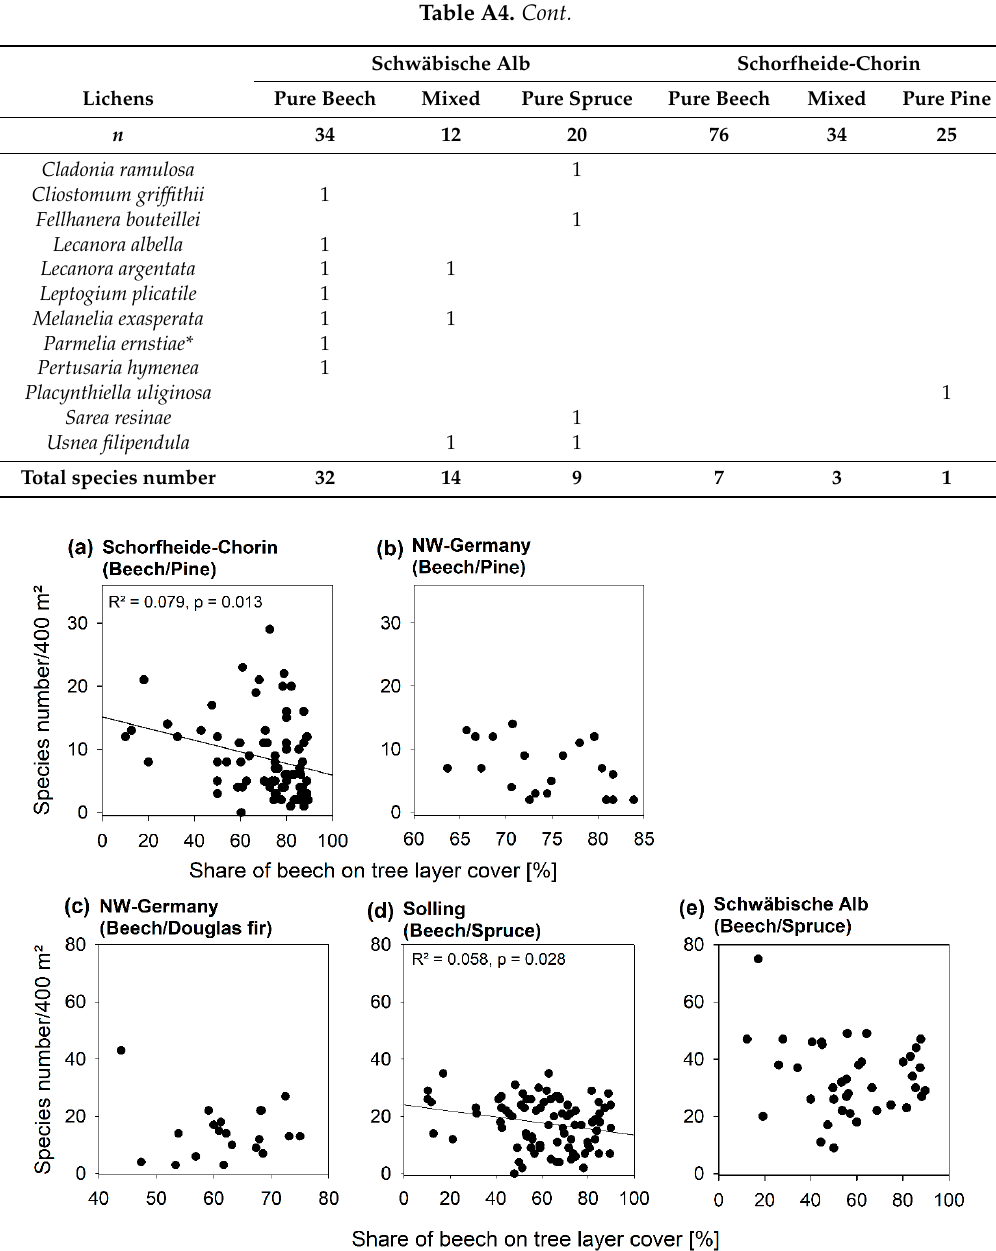
Figure A1. Vascular plant species numbers per 400 m 2 plots in relation to the percentage share of beech on tree layer cover within mixtures ( a ) of beech and pine in Schorfheide-Chorin and ( b ) NW-Germany, ( c ) of beech and Douglas fir in NW-Germany, ( d ) beech and spruce in Solling and ( e ) Schwäbische Alb. Plots were characterized as mixtures when both target species (beech and conifer) had a minimum of 10% or maximum of 90% share on accumulated tree layer cover. Regression lines and results are printed when relationships were significant. Note that the scale of the y-axis differs for Beech/Pine and Beech/Spruce(Douglas fir) combinations.